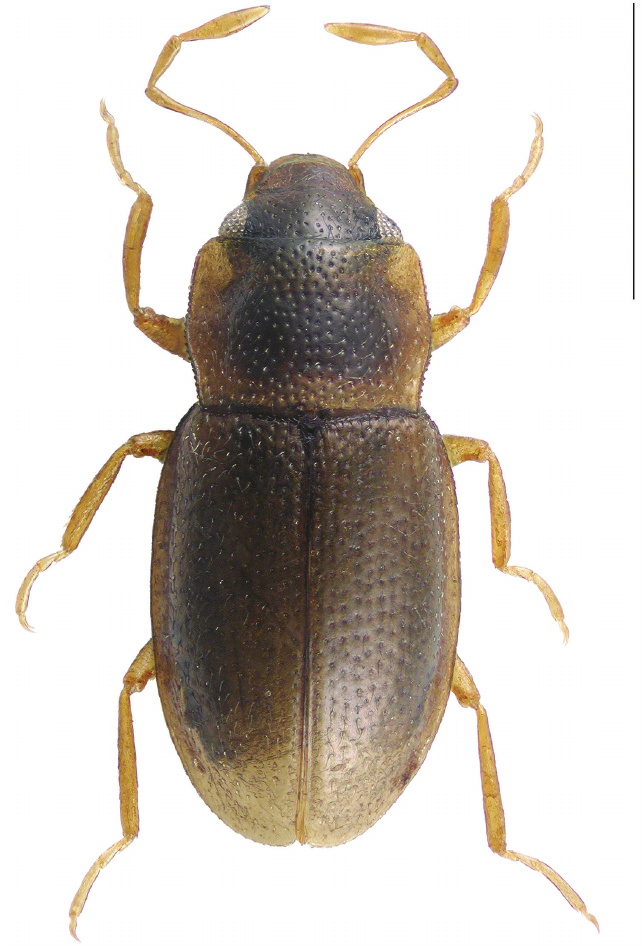
Figure 1. Habitus of Hydraena mahensis Scott, 1913, male. Scale bar: 0.5 mm. Redescription. Habitus as in Fig. 1. Body length (without abdomen): 1.20–1.40 mm. Dorsum brown, frons dark brown to black, posterior and lateral sides of prono- tum paler yellowish brown; maxillary palpi and legs yellowish to yellowish brown. Labrum deeply excised anteriorly; lobes rounded anteriorly. Middle of clypeus very sparsely punctate and glabrous, lateral parts densely micropunctate and mat. Fronto- clypeal suture more or less straight, slightly impressed. Frons moderately densely punc- tate laterally, sparsely punctate medially, interstices shining; interocular grooves obso- lete. Eyes large, protruding, more than 30 facets visible in dorsal view. Pronotum wider than long, widest near middle; anterior margin weakly concave; anterior angles rounded; lateral rim denticulate; surface moderately densely punctate, but disc sometimes more sparsely punctate; discal foveae more or less